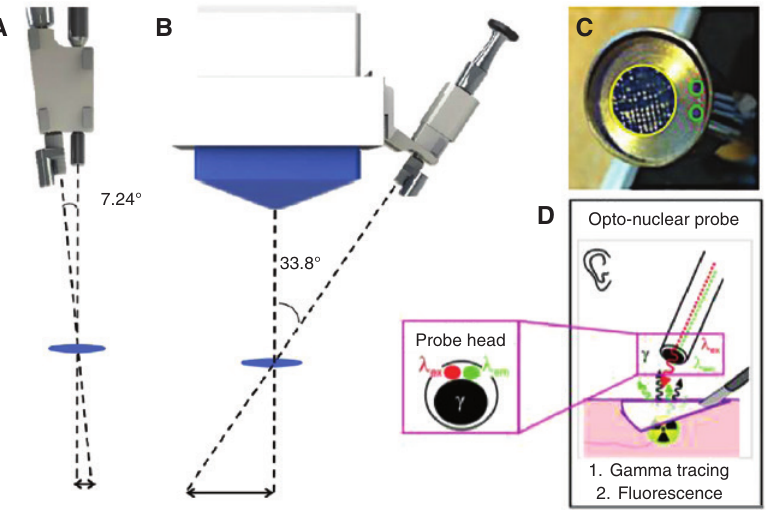
Figure 9: Dual modal imaging devices composed of a gamma probe/camera and a fluorescence camera to image fluorescence and gamma